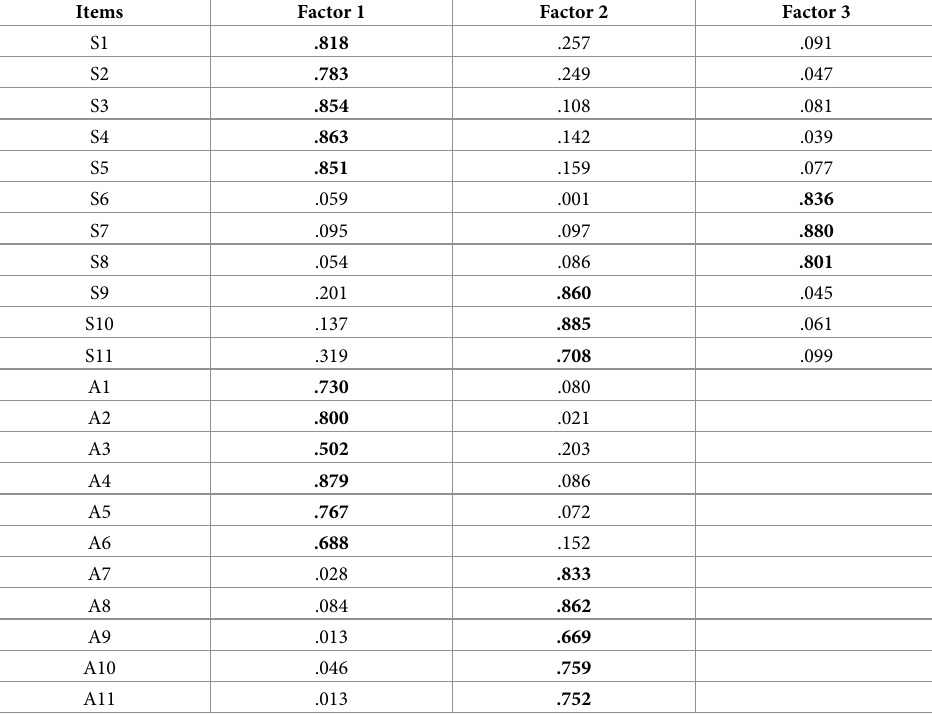
Table 2. Factor loading matrix of the Chinese version of SE-PMC and A-PMC (n = 427). Items Factor 1 Factor